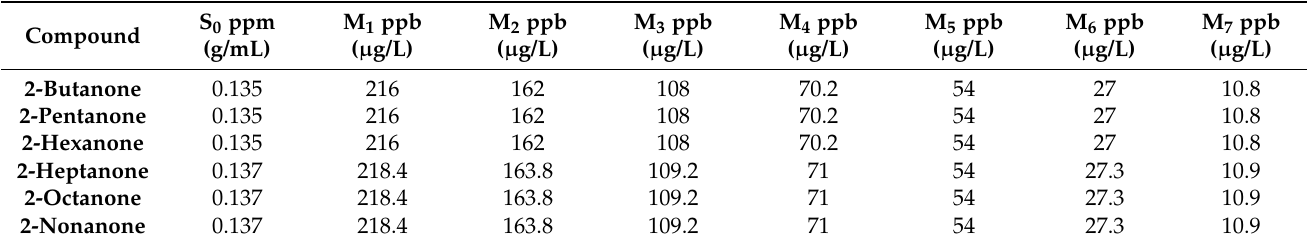
Table 1. Concentration values of ketone mixture standard solutions used for column normalisation and for